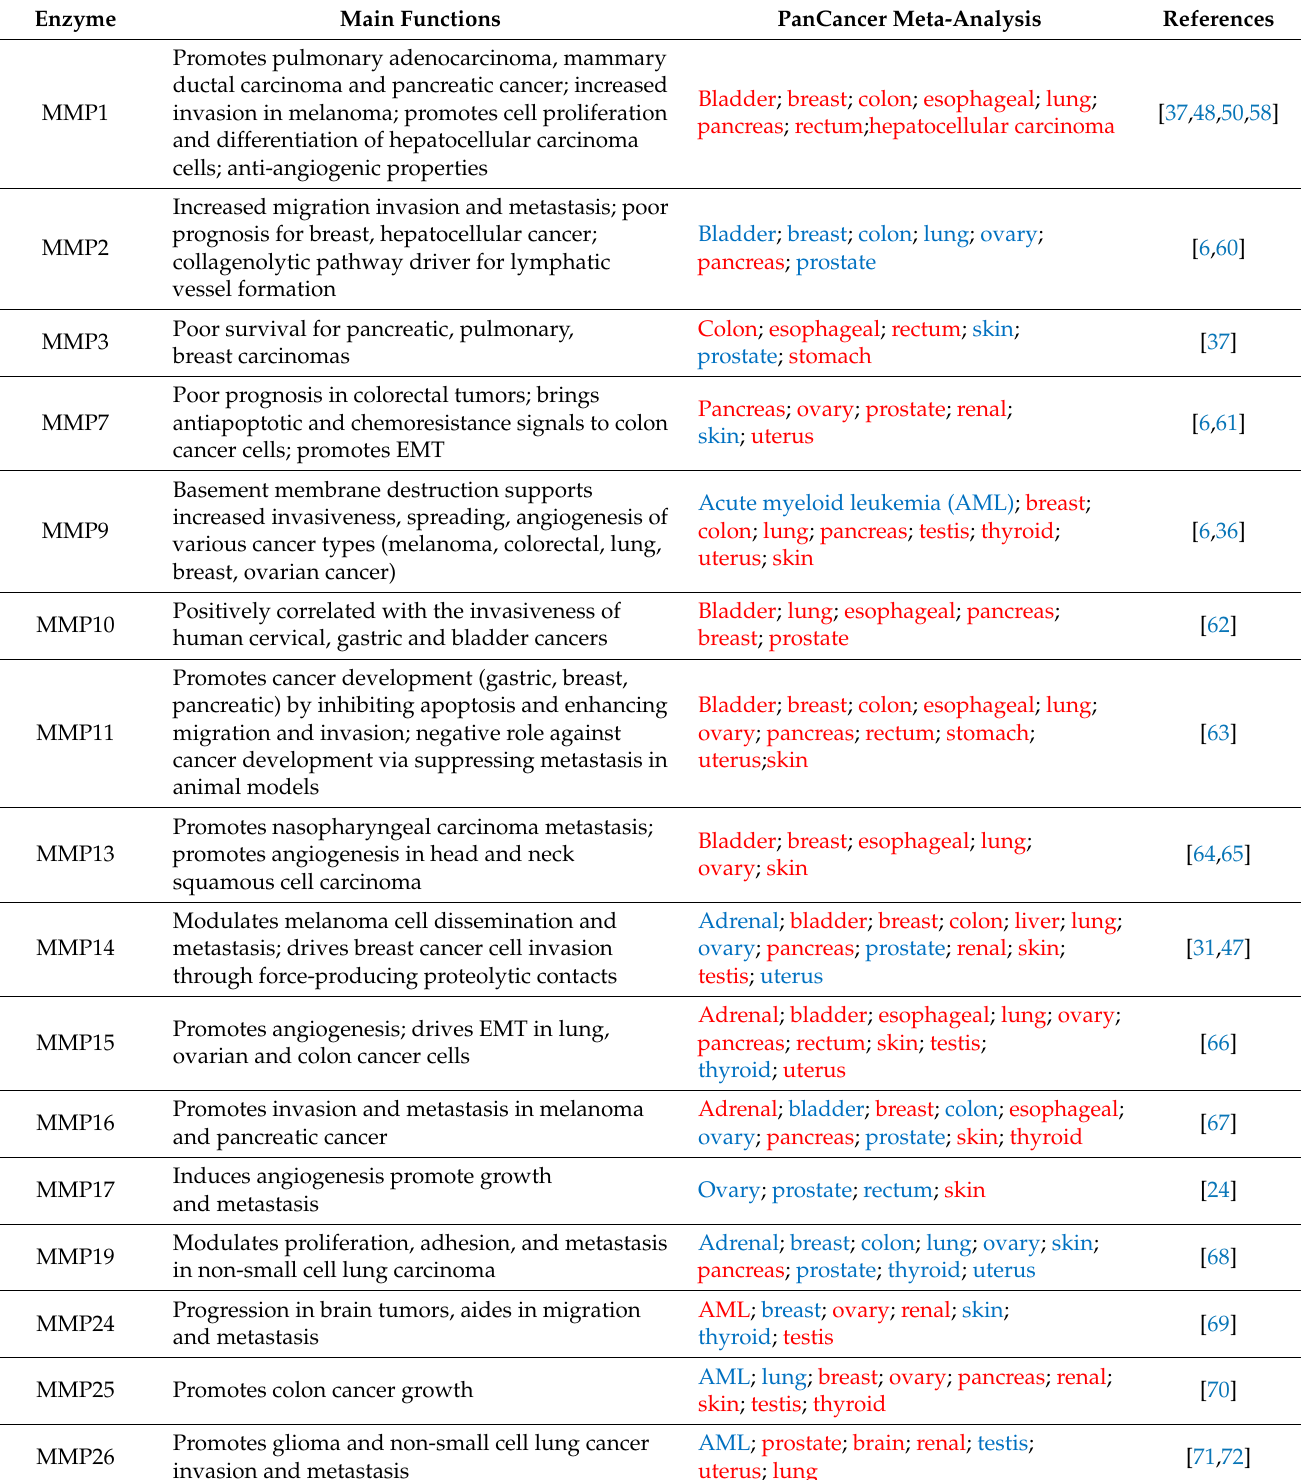
Table 1. The main functions of major MMPs and TIMPs in cancer progression. Their prognostic value has been estimated by pan-cancer analysis in all available normal and tumor RNA Seq data from GEO, TCGA and GTex databases [59]. Significant differences of expression in tumor tissues compared to normal expression are marked with red (upregulation) and blue (downregulation) and have been computed by Mann–Whitney U